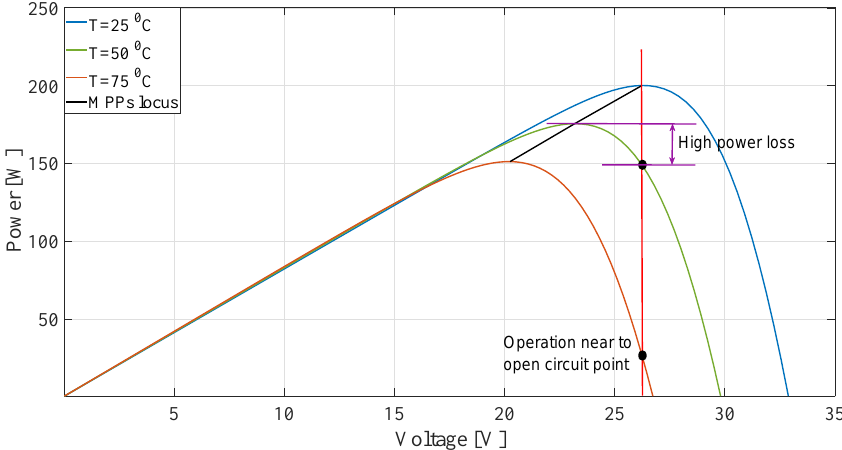
Figure 10. MPP voltages’ variation range with different temperature